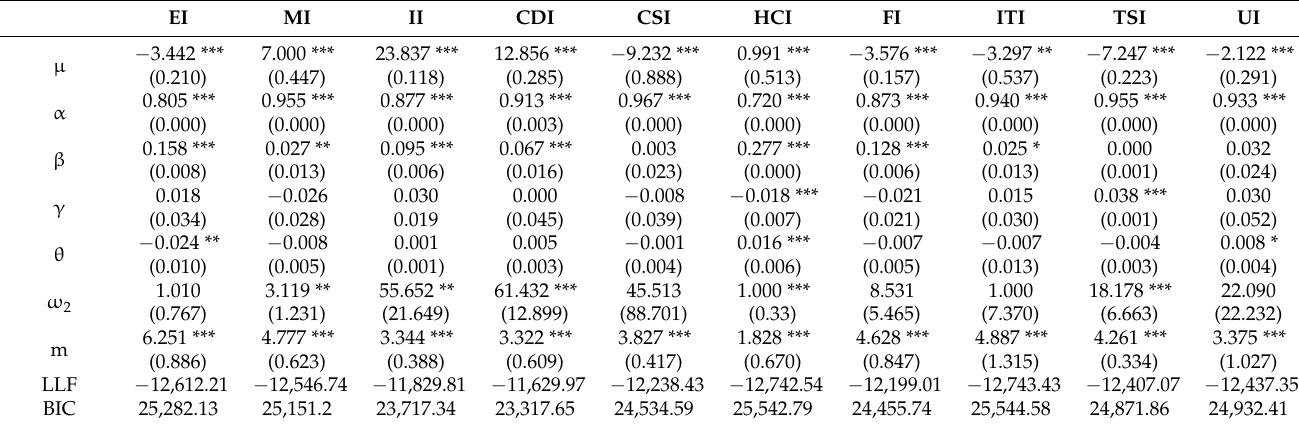
Table 9. GARCH-MIDAS regression results of EPU_US index on volatility spillover levels of various industries in China 7